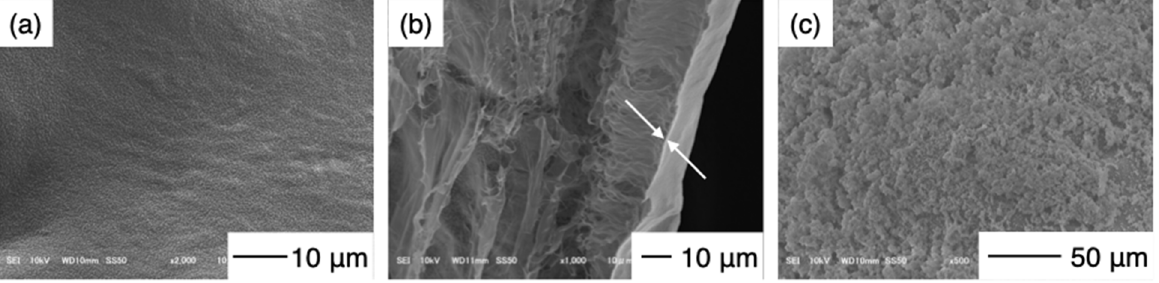
Figure 6. SEM images of the ChG2 capsule surface. ( a ) The outer surface and ( b ) the cross-section. The arrows indicate the wall of the capsule. ( c ) The outer surface following HAp deposition.